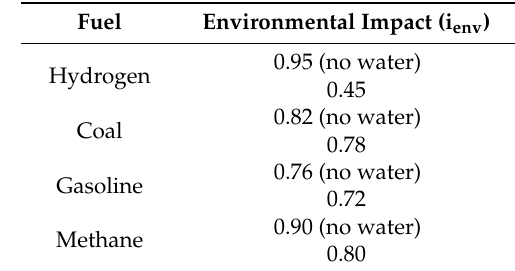
Table 1. Global environmental index for various fuels (Adapted from [4]).